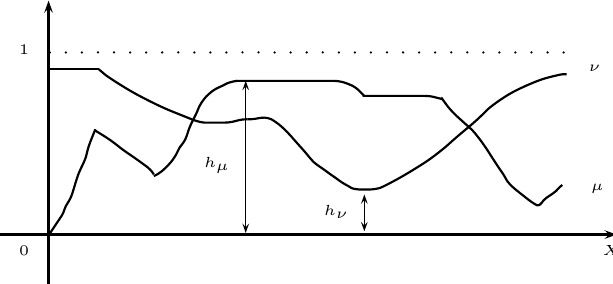
Figure 2. Geometric interpretation of height of q -ROFS ( q -rung orthopair fuzzy Figure 2.2: Geometric interpretation of height of q -ROFS